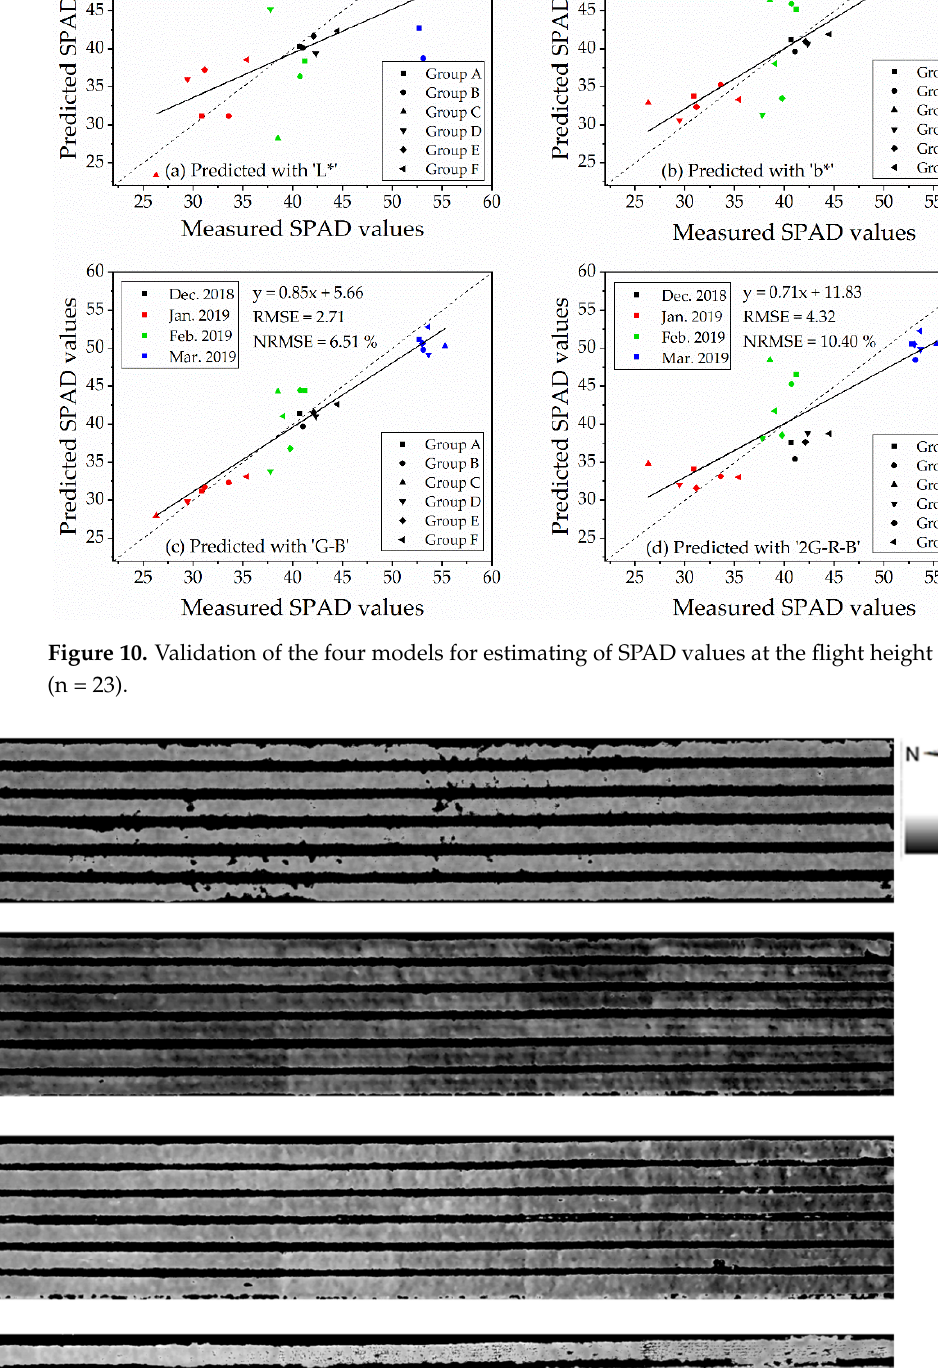
Figure 9. Validation of the four models for estimating of SPAD values at the flight height of 6.0 m (n = 23).